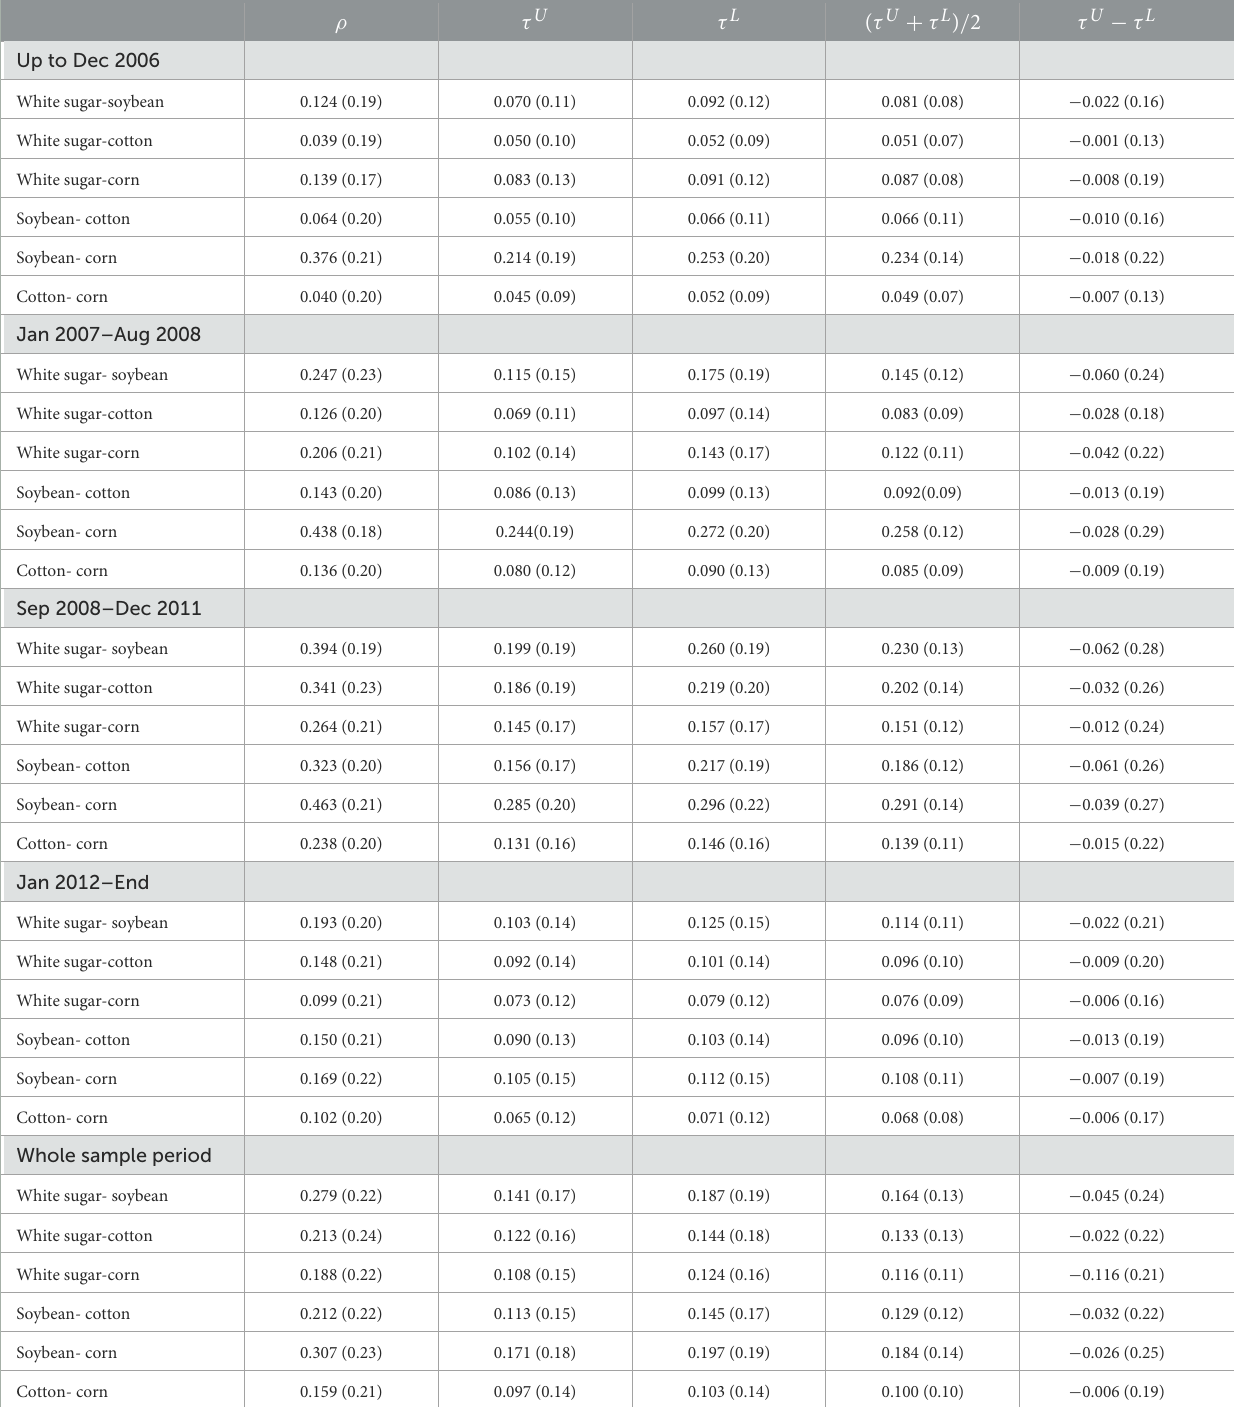
TABLE 4 Mean of dependence measures and its corresponding standard deviations for whole sample period and four sub-periods.